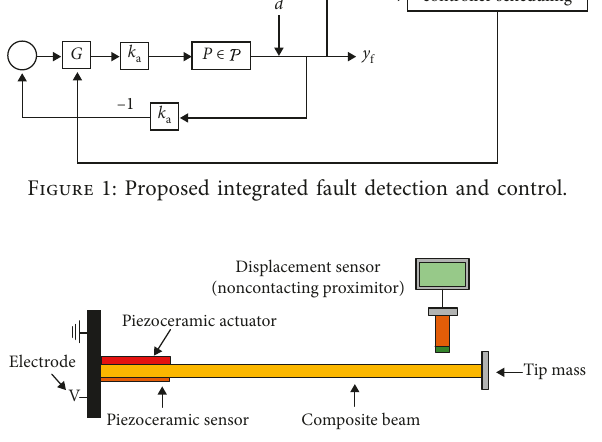
Figure 2: Schematic diagram of the smart